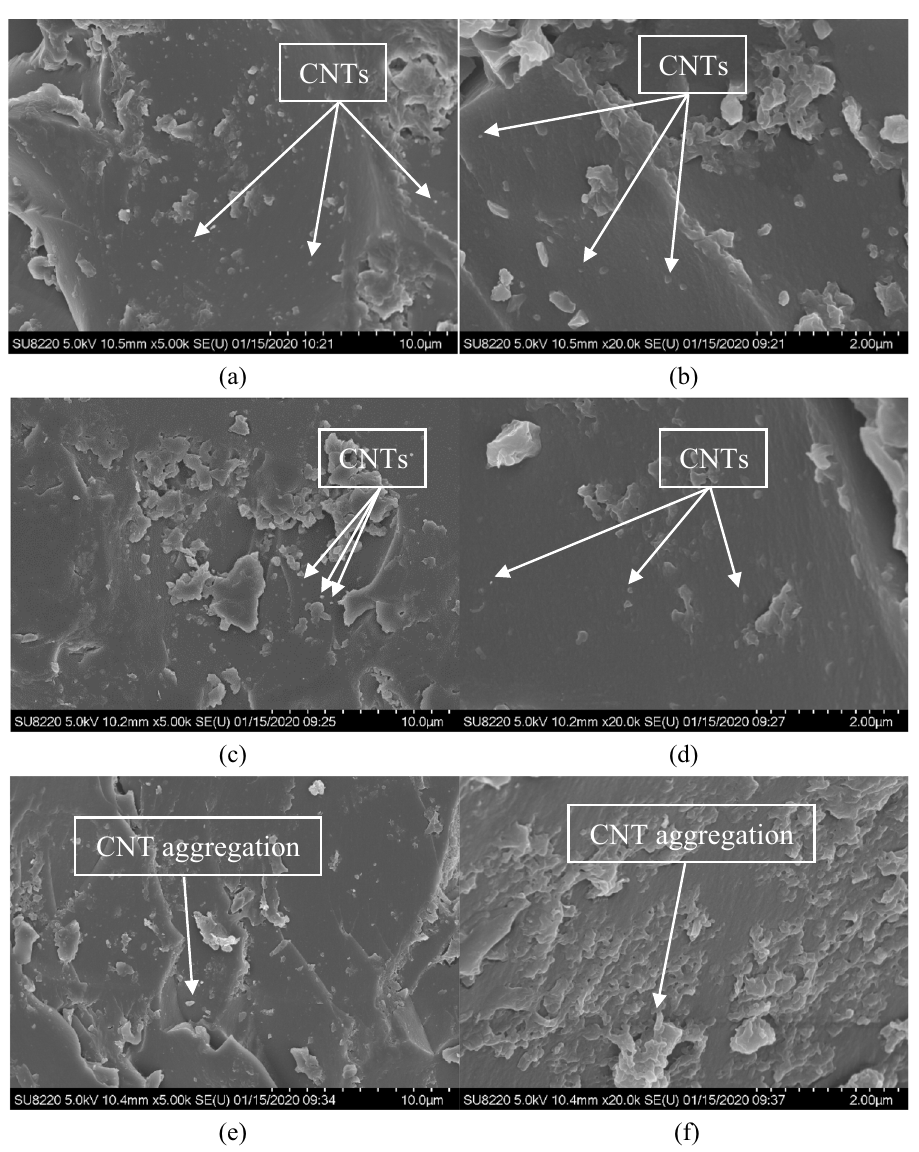
Figure 13: Microstructure imaging of CNT - reinforced epoxy at 0.1 wt% CNTs at ( a ) 5,000 × and ( b ) 20,000 × ; 0.4 wt% CNTs at ( c ) 5,000 × and ( d ) 20,000 × ; 0.6 wt% CNTs at ( e ) 5,000 × and ( f ) 20,000 ×